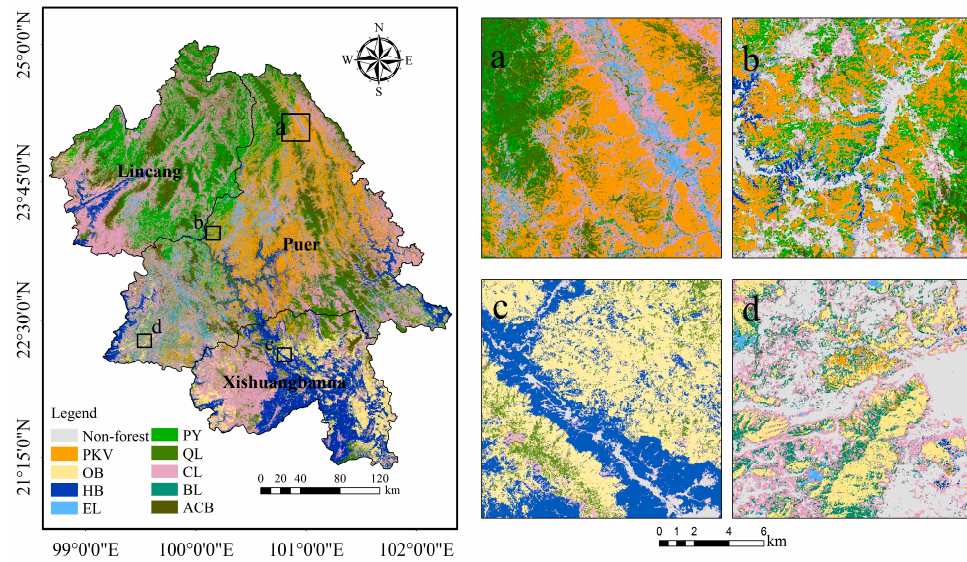
Figure 5. Mapping tree species with all feature combinations. ( a – d ) show the spatial details of the tree species map.